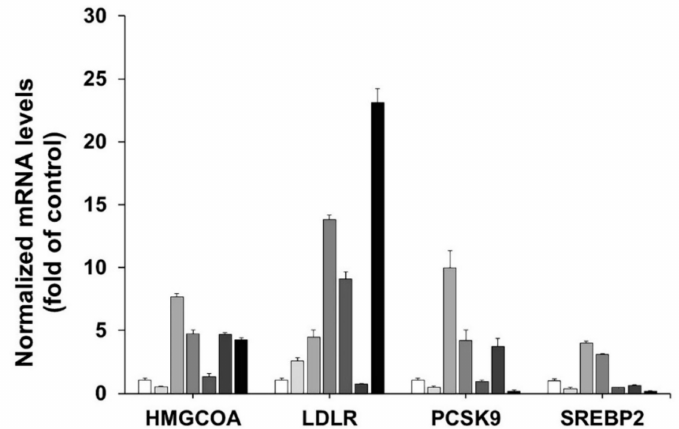
Figure 2. Effects of aqueous and ethanolic extract of Z. officinale , C. tinctorius , and C. fenestratum on mRNA expression levels. The bar graphs go from white (left) to black (right), indicating the control (white), the ethanolic extract of Z. officinale (light gray), C. tinctorius (medium gray), C. fenestratum (dark gray), the water extract of Z. officinale (light black), C. tinctorius (medium black), and C. fenestratum (black)